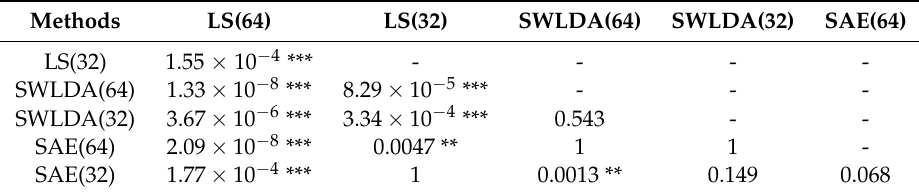
Table 2. Adjusted (Bonferroni correction [32]) p -values of pairwise multiple comparisons using Wilcoxon signed-ranks